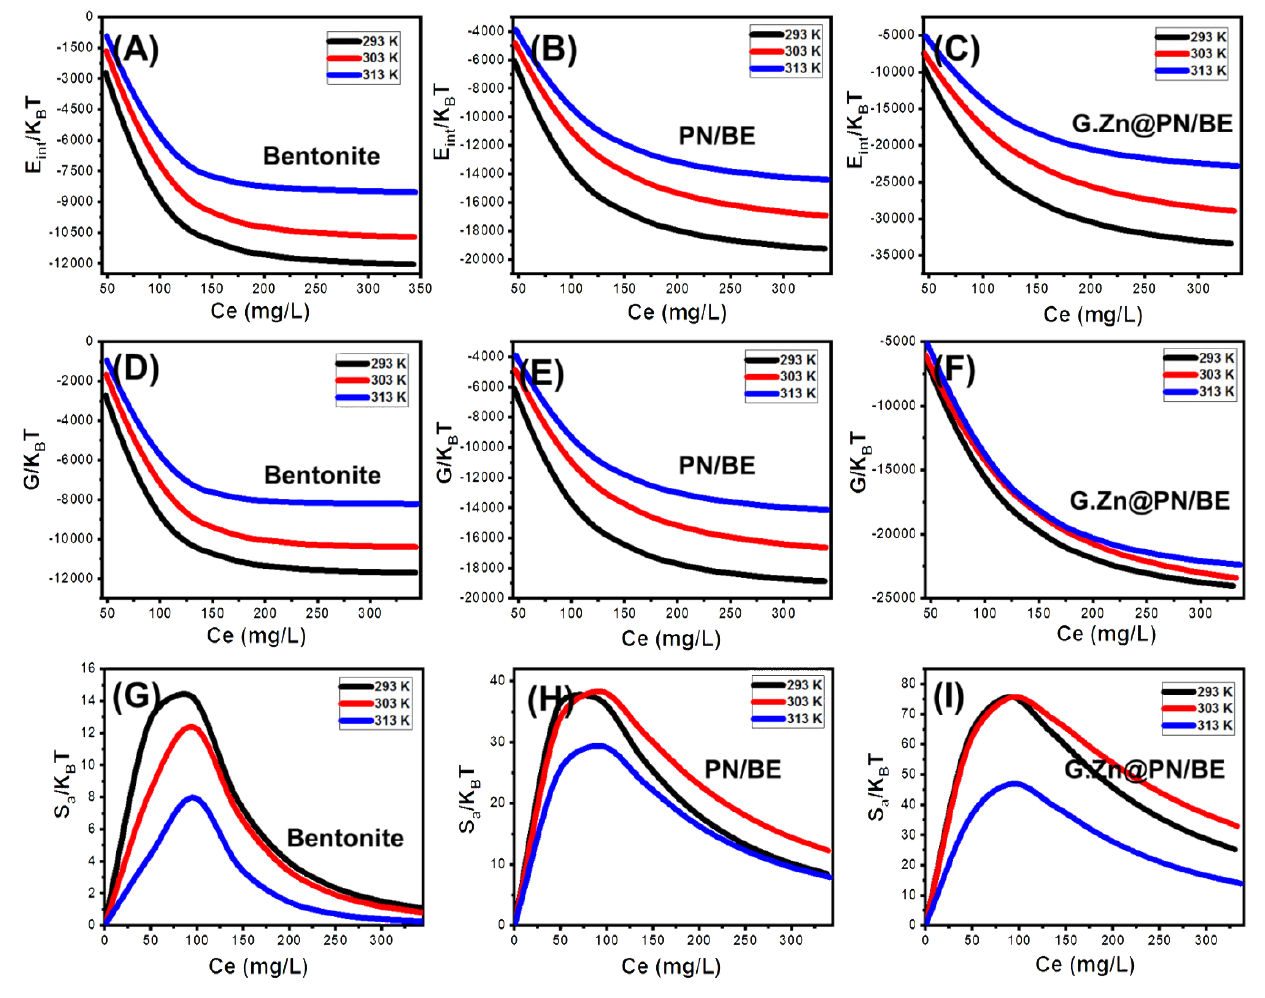
Figure 8. The behavior of the internal energy (E int ) during the retention processes at different con- centrations of As (V) ions ( A ‒ C ), the behavior of the free enthalpy during the retention processes at concentrations of As (V) ions ( A – C ), the behavior of the free enthalpy during the retention processes different concentrations of As (V) ions ( D ‒ F ), and the behavior of the entropy (Sa) during the re- at different concentrations of As (V) ions ( D – F ), and the behavior of the entropy (S a ) during the tention processes at different concentrations of As (V) ions ( G ‒ I ). retention processes at different concentrations of As (V) ions ( G – I